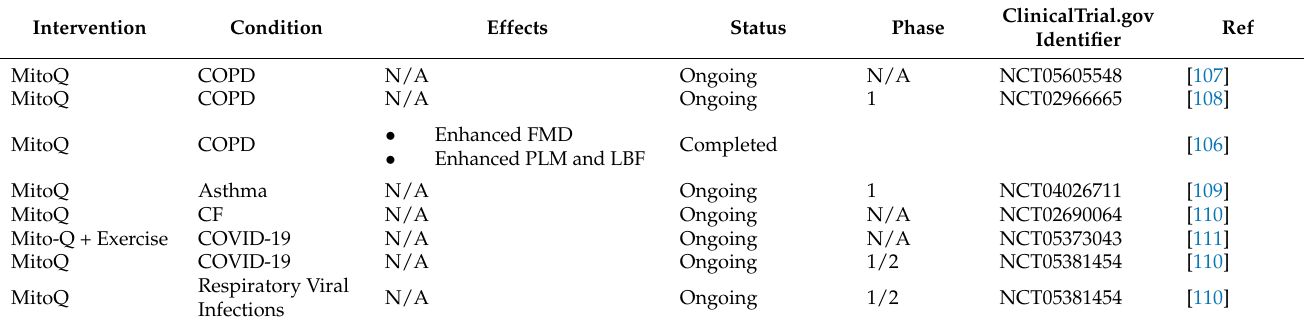
Table 2. Mitochondria-targeted antioxidants in clinical trials for chronic lung disease.